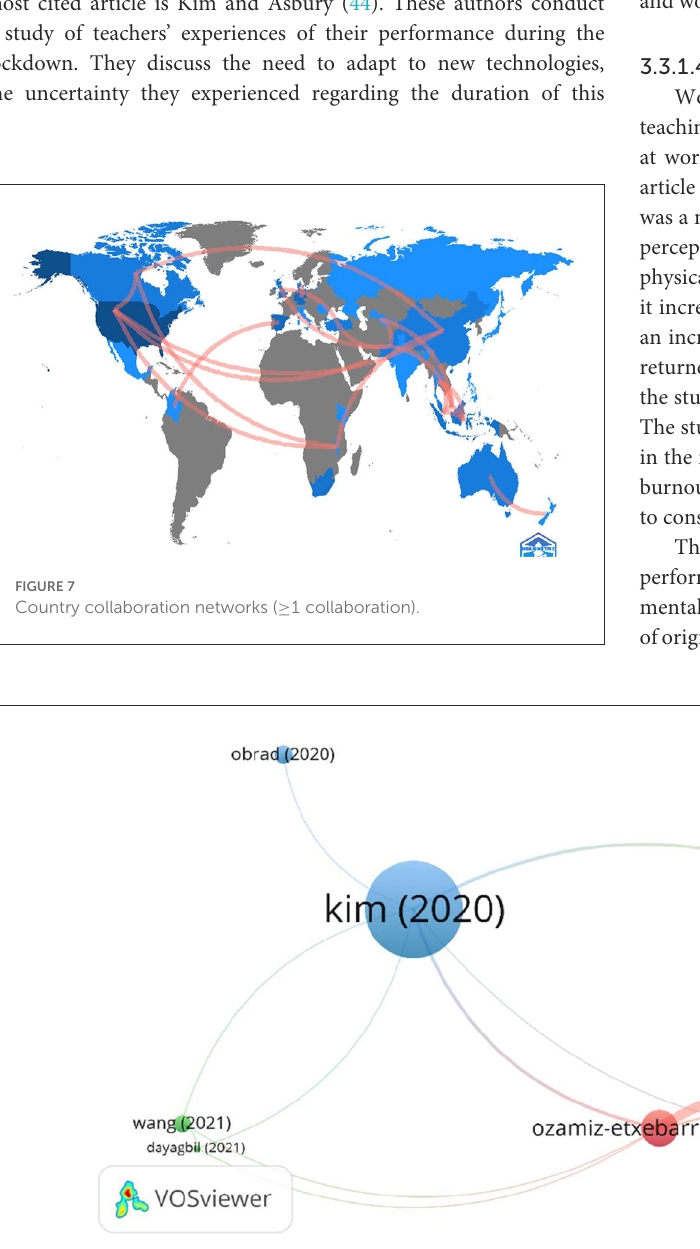
FIGURE8 Bibliographic coupling analysis for documents ( ≥ 2 citations of